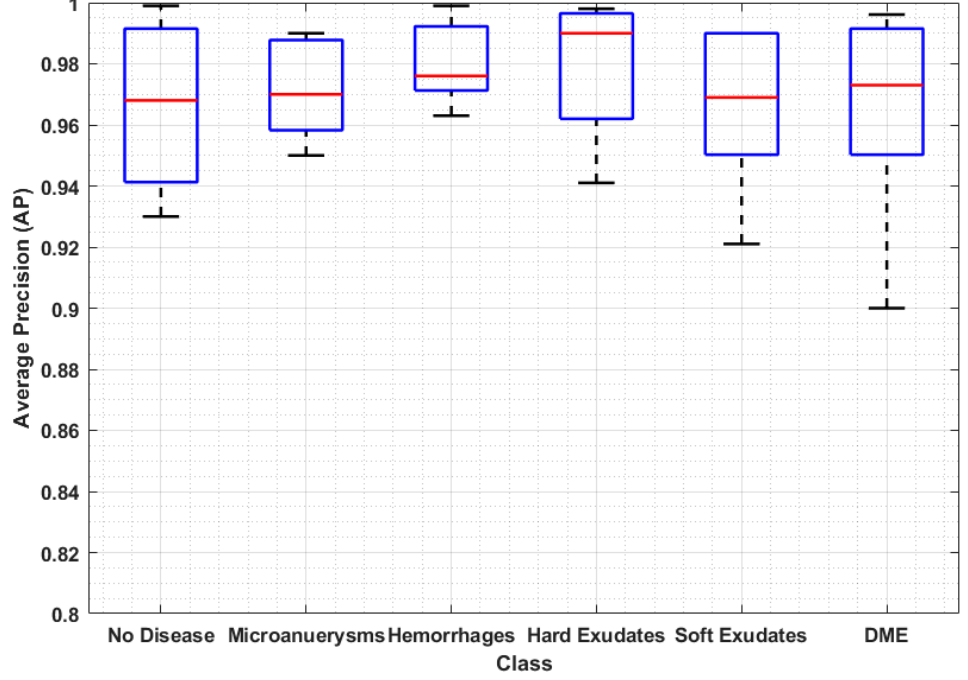
Figure 7. Average precision results of the proposed method.